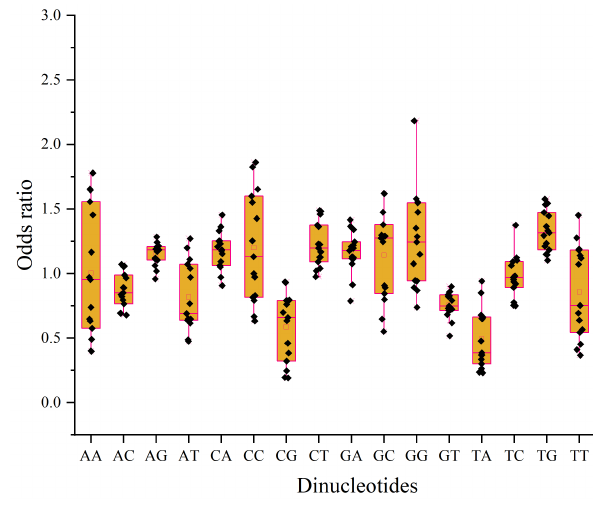
Fig.3. Jitterandboxplotshowing thevaluesoftheodds ratioofdin- ucleotides. The figure depicted that maximum variation in odds ratio was present in the case of ApA and CpC. At the same time, dinucleotides ApC, ApG, CpA, CpT, GpA, GpT, TpC, and TpG showed least the variation in odds